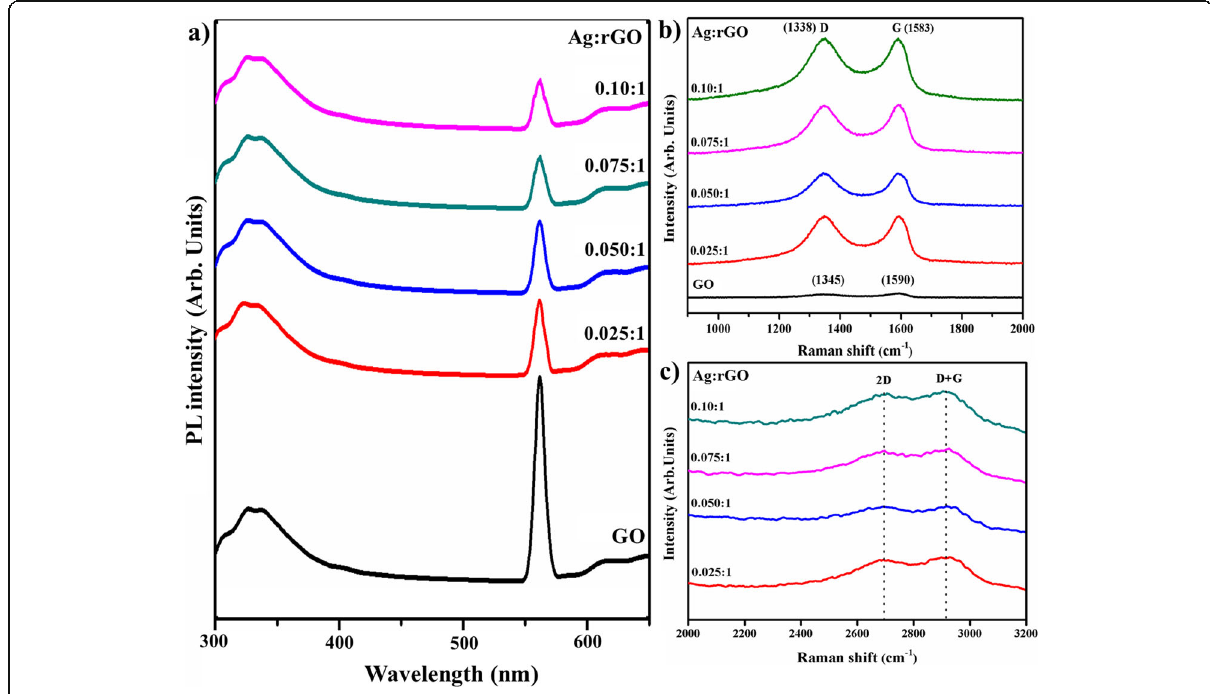
Fig. 7: a PL spectra. b Raman spectra of prepared samples. c Zoom area of Raman